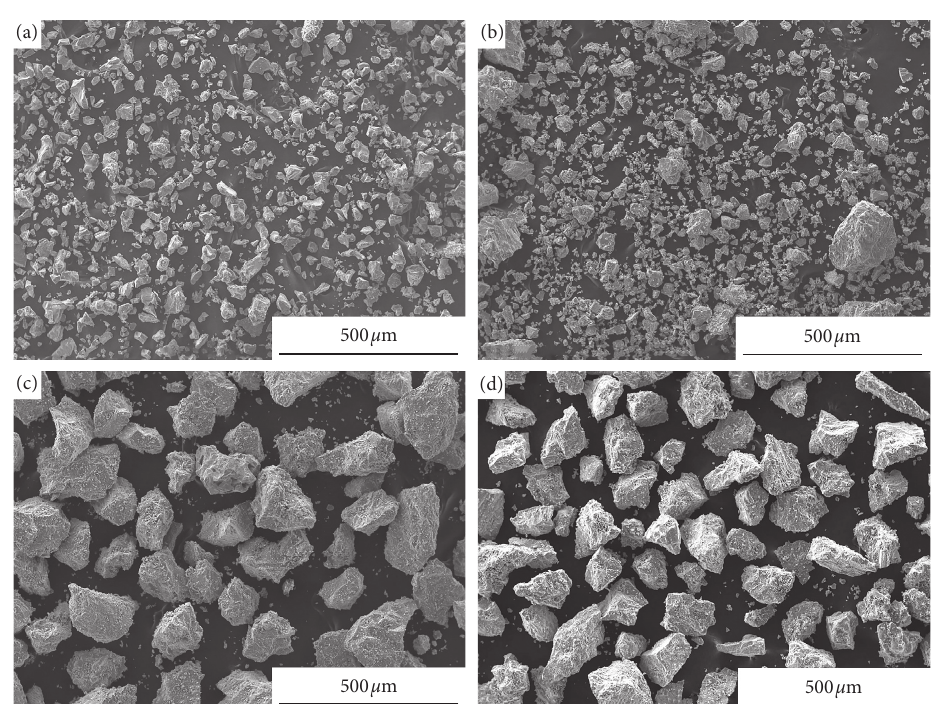
Figure 2: The SEM micrographs of initial powders: (a) 0–38 μ m TiH 2 , (b) 0–125 μ m TiH 2 , (c) 88–125 μ m TiH 2 , and (d) 88–125 μ m HDH Ti.